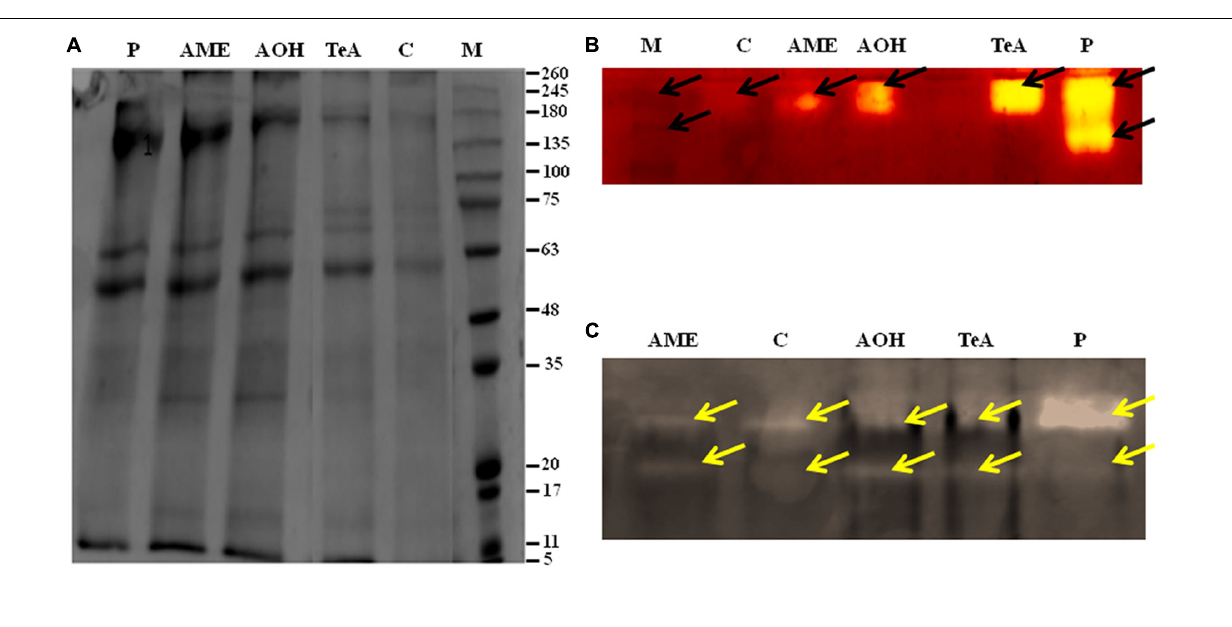
FIGURE 8 | (A) Protein pattern (SDS-PAGE) of soluble protein extracted from stressed tomato plants leaves infected by A. alternata and treated with its toxins as compared to the control. Arrows indicate the increase and decrease in intensity after infection. Isoenzyme profile of (B) Superoxide dismutase (SOD), and (C) Catalase (CAT) infected by A. alternata and treated with its